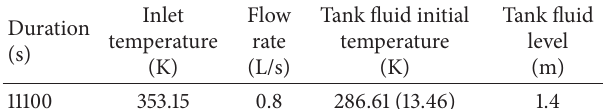
Table 2: Summary of test conditions.